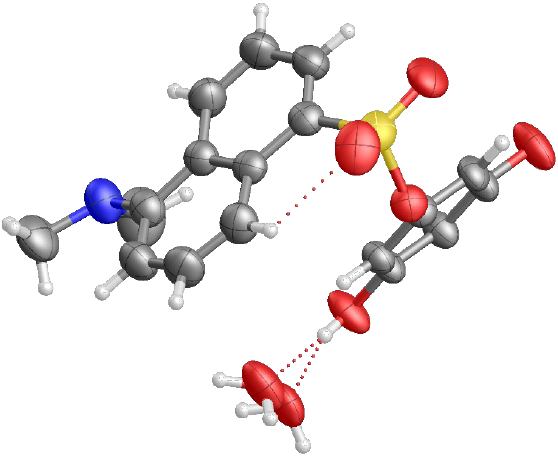
Figure 2. Hydrogen bonding in sensor R1.